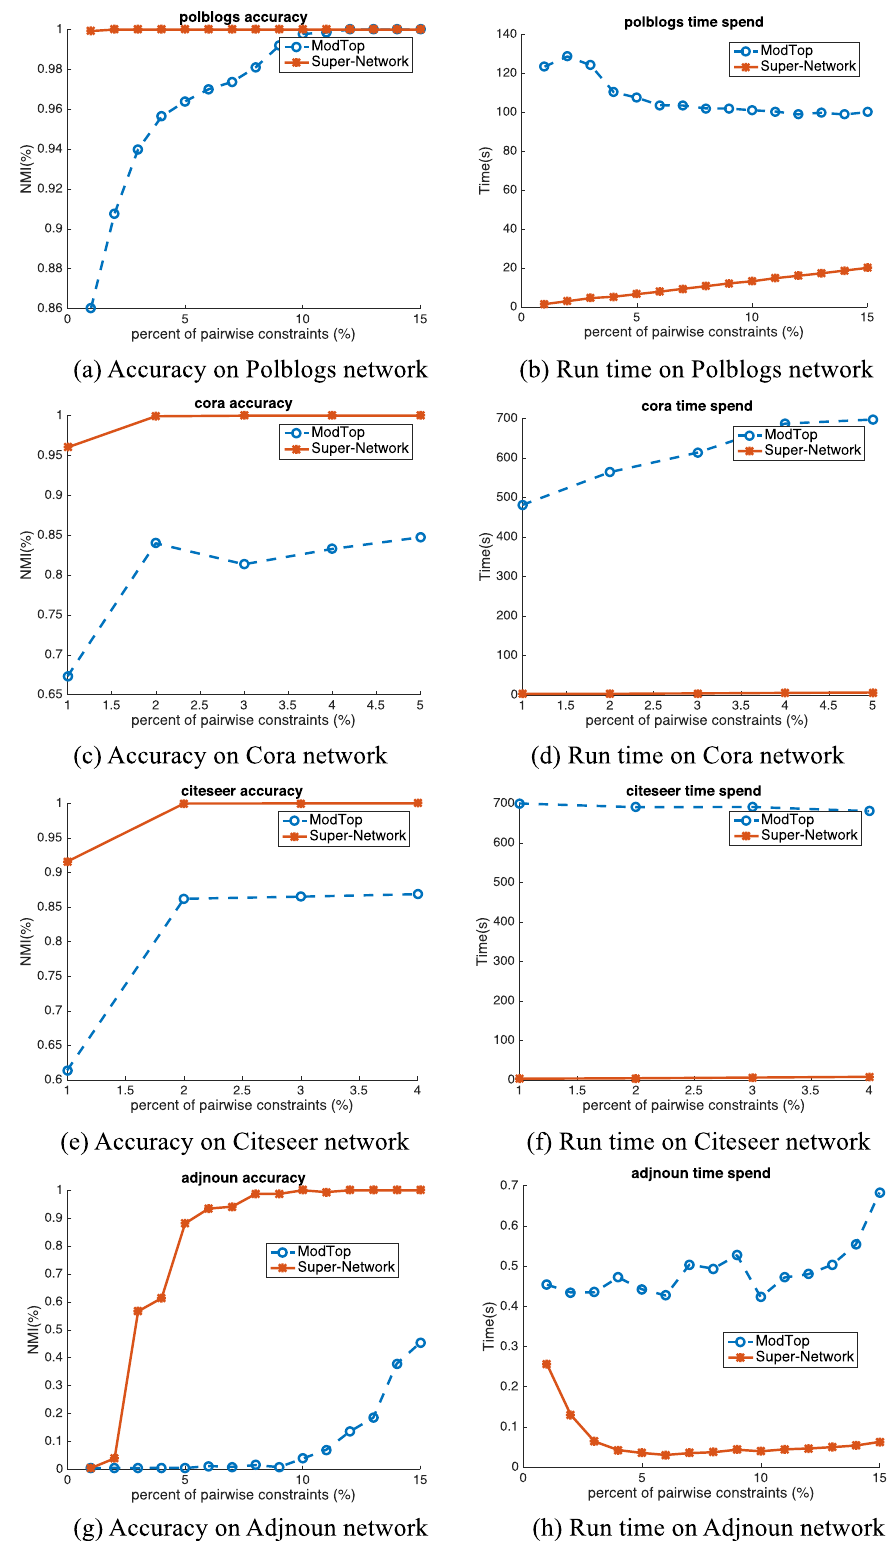
Figure 7. Accuracy (NMI) and run time (spent time in second) on four real world networks based on